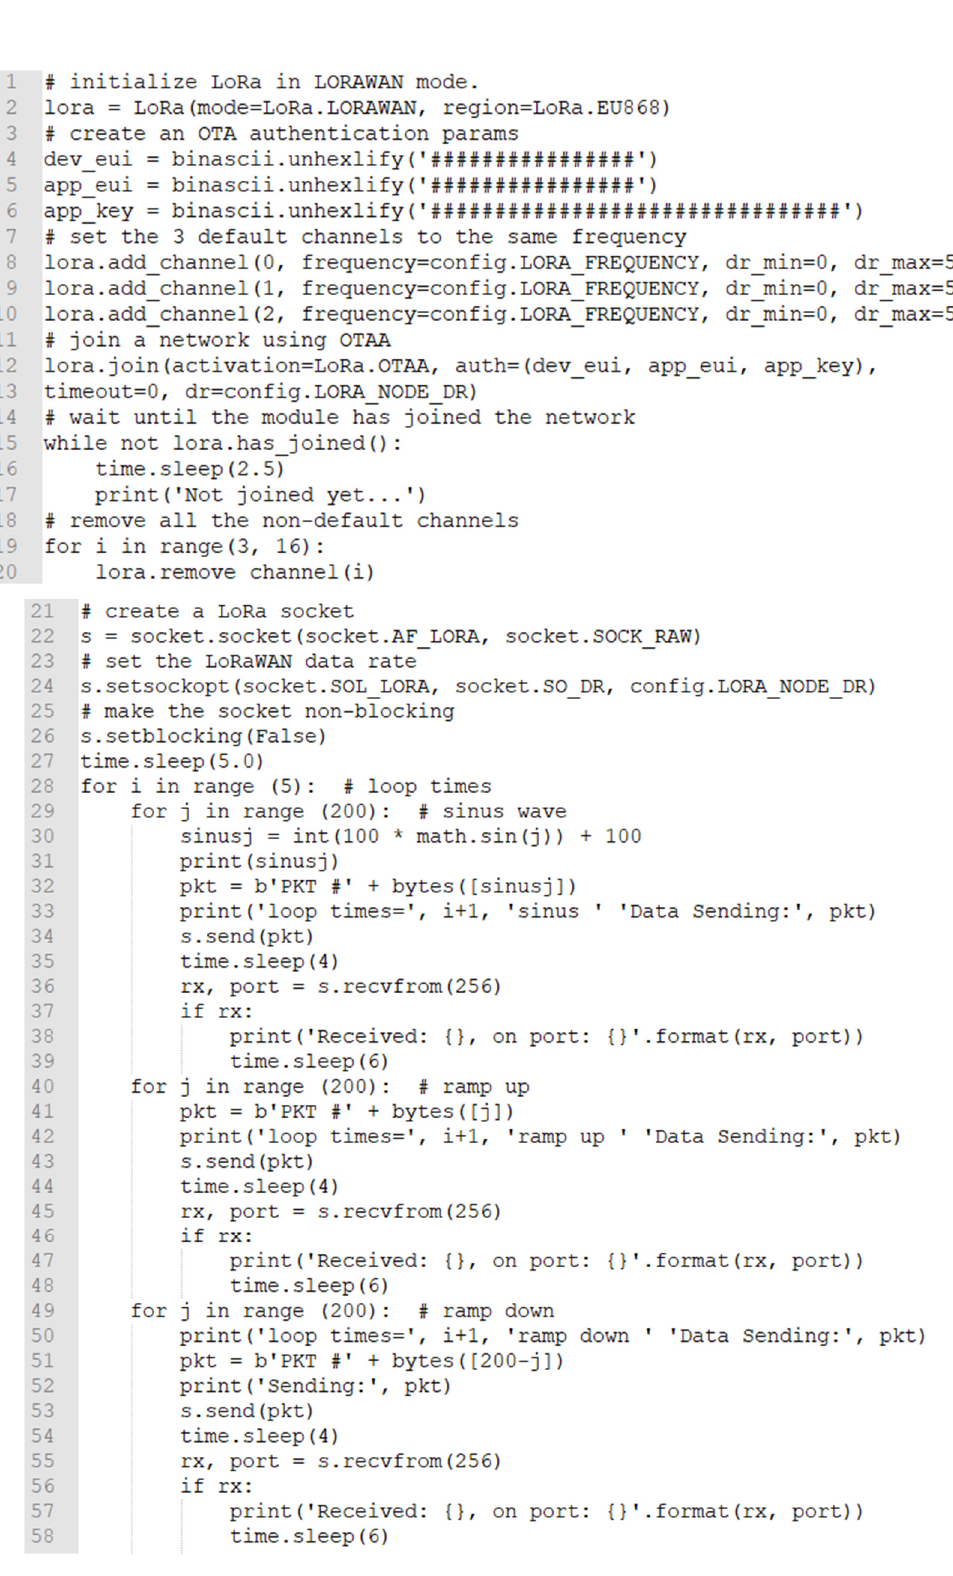
Figure 6. Part of the initialization and parameters configuration of LoRa-enable LoPy4 nodes.